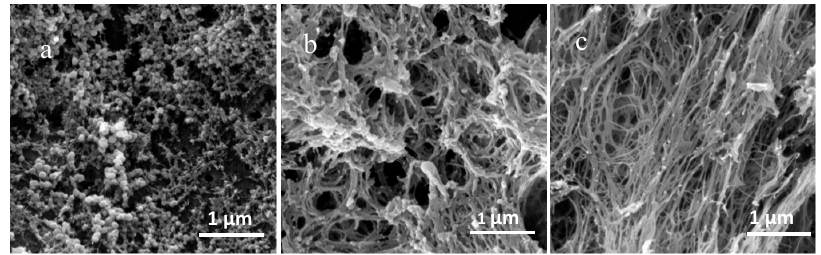
Figure 2. The SEM images of xanthan gum-based hydrogel ( a ) and eutectogels with different water contents ( b ) 60%, ( c ) 20%.